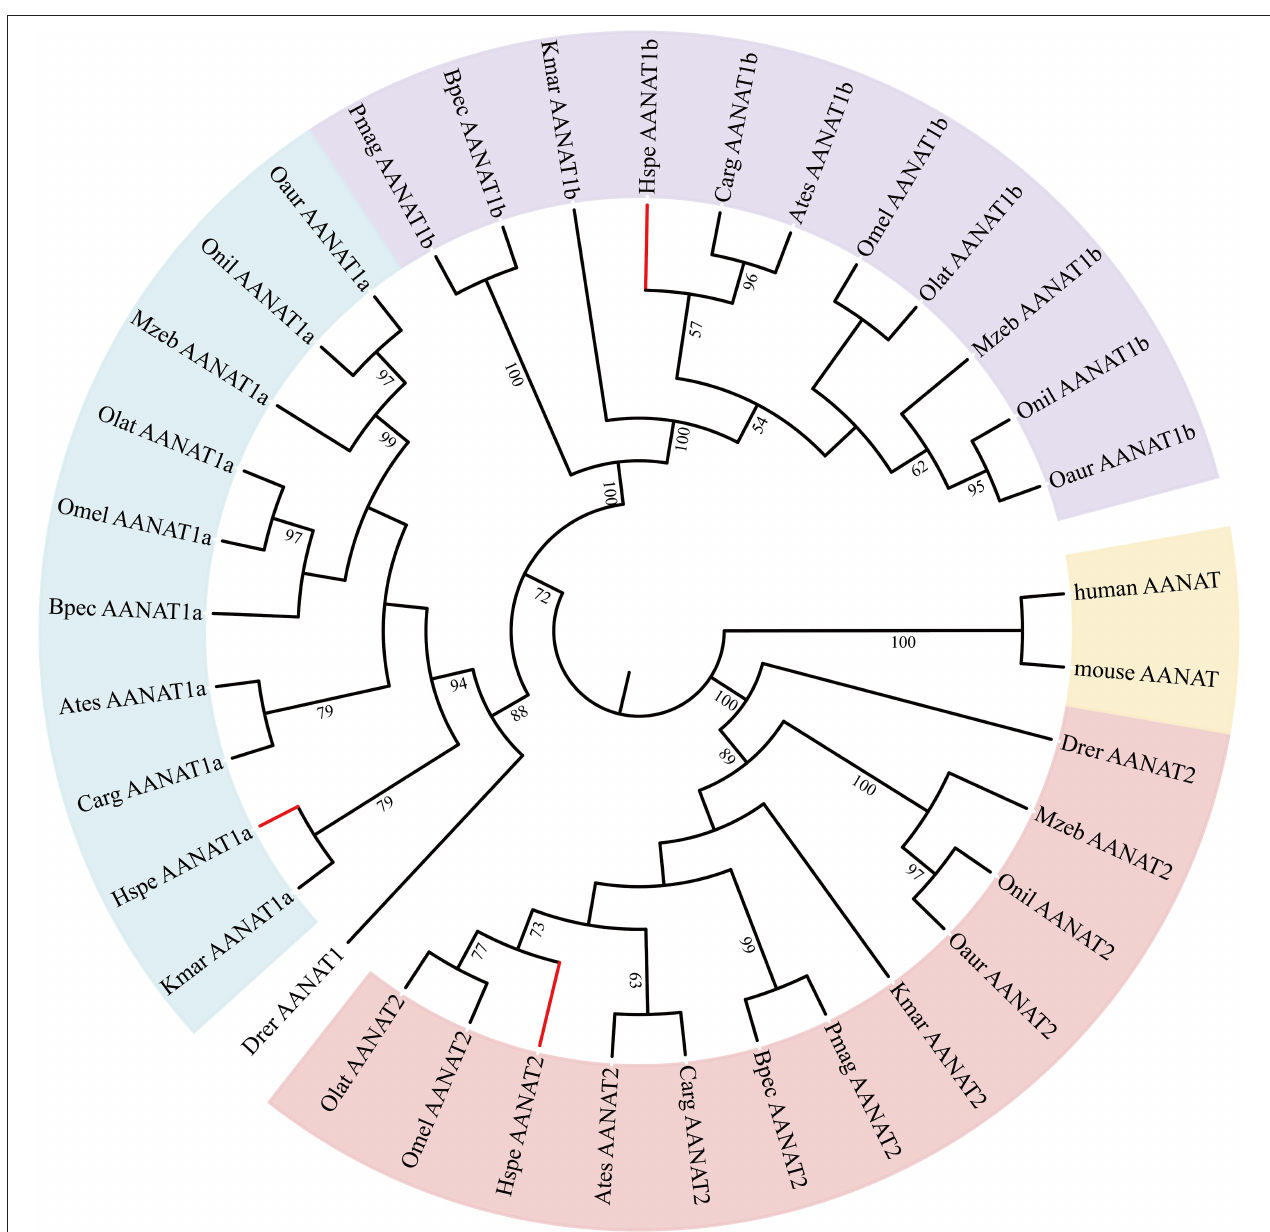
FIGURE 3 | The rooted NJ tree of vertebrate aanat genes. It was constructed with human AANAT (NP_001079.1) and mouse AANAT (NP_033721.1) as the outgroup.